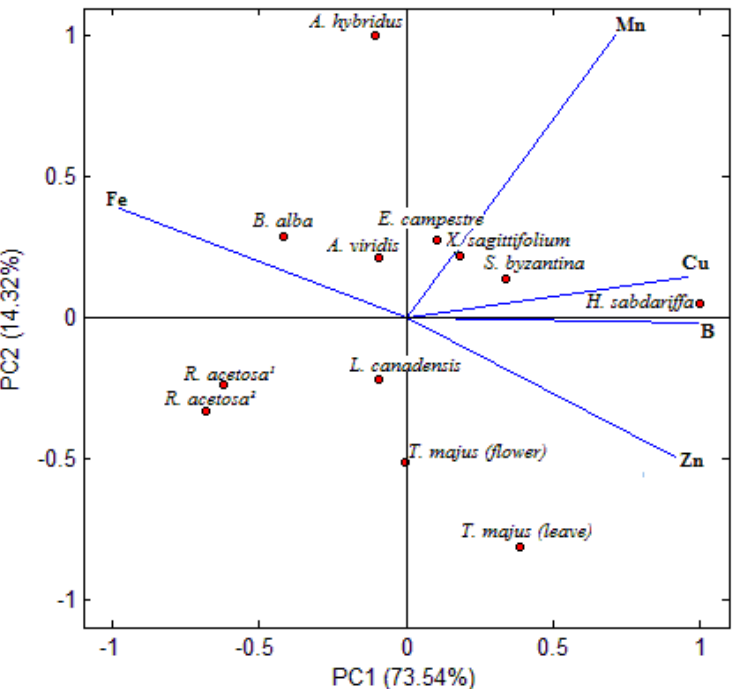
Figure 4 - Analysis of the main components related to the observed results for the constitutions of the species and structures in the micronutrient Fe, Cu, Mn, Zn levels.